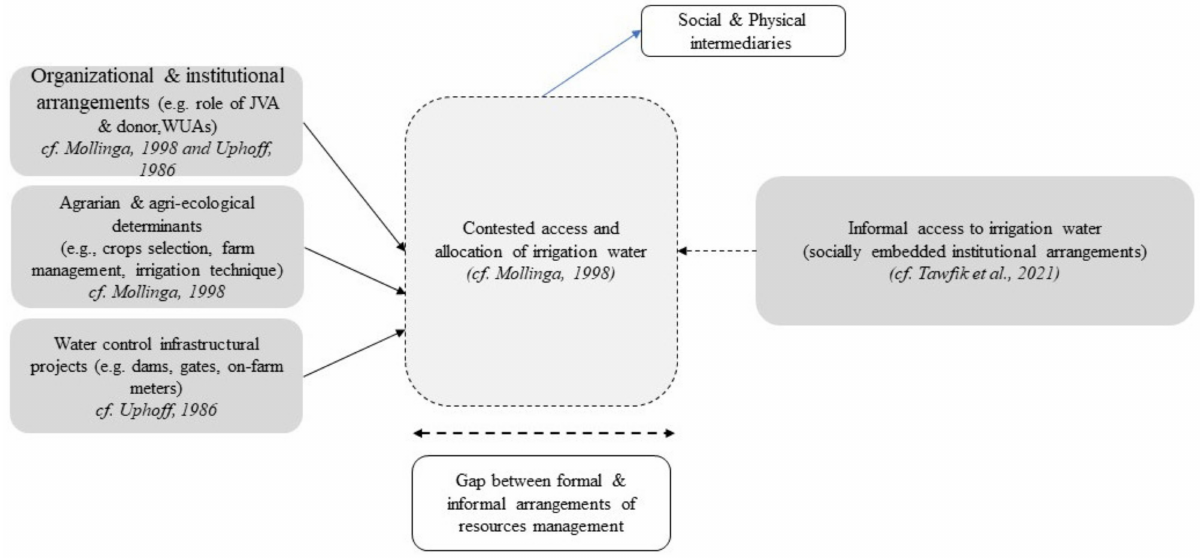
Figure 1. Combining Mollinga’s (1998) and Uphoff’s (1986) analytical frameworks